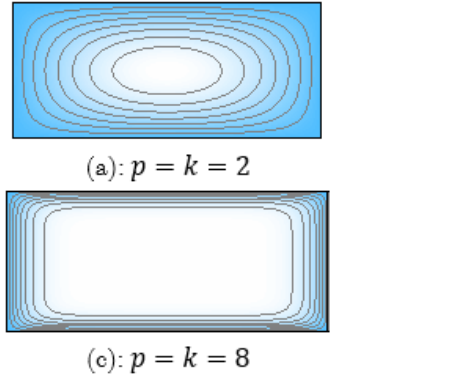
(cid:0) (cid:1) R x = R y = ∞ .